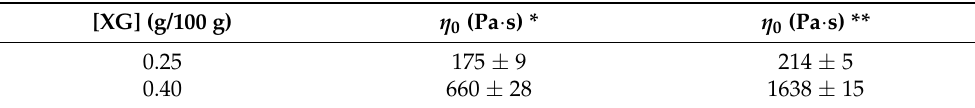
Table 3. Comparison of the zero shear viscosity values of the weak gel advanced performance xanthan gum systems containing fennel oil nanoemulsion (* this work) or without fennel oil nanoemulsion (**, Reference [21] by Carmona et al.).